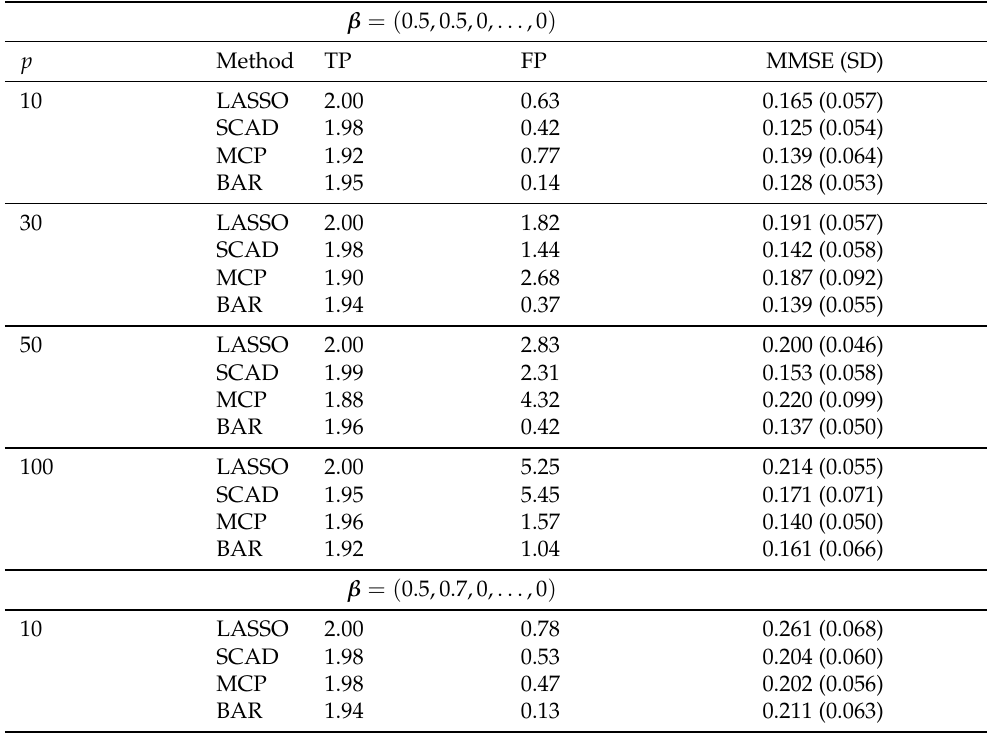
Table 3. Simulation results based on the joint selection of the tuning parameter and bandwidth n = 300 for